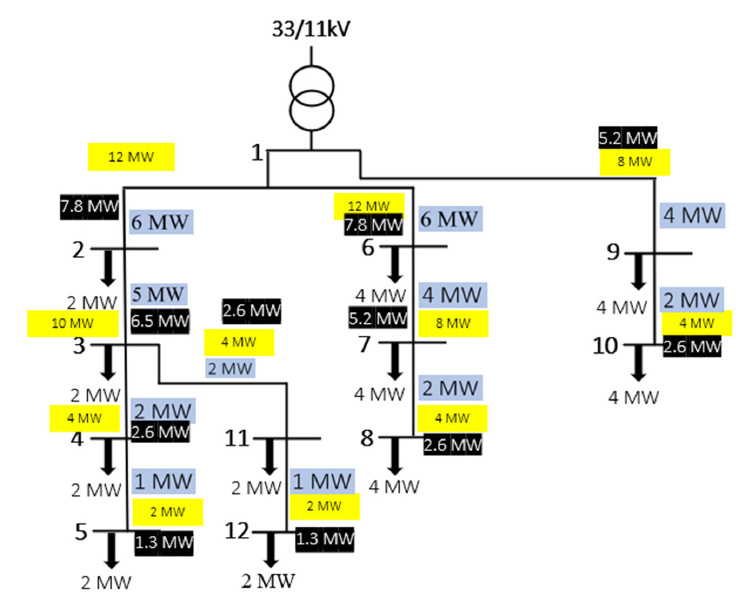
Figure 5. Schematic diagram of the HV electricity grid showing the first-stage power flows (in blue), the initial line thermal limits (in black), and the second-stage peak load (downward black arrows)